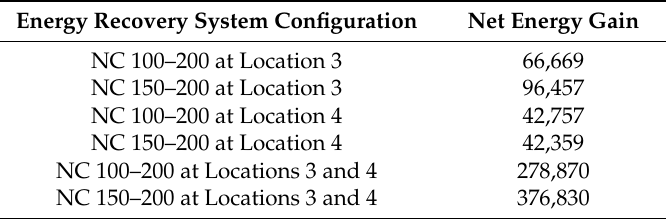
Table 3. Energy budgets (kWh/y) for the candidate energy recovery system configurations in the gravity-driven network.